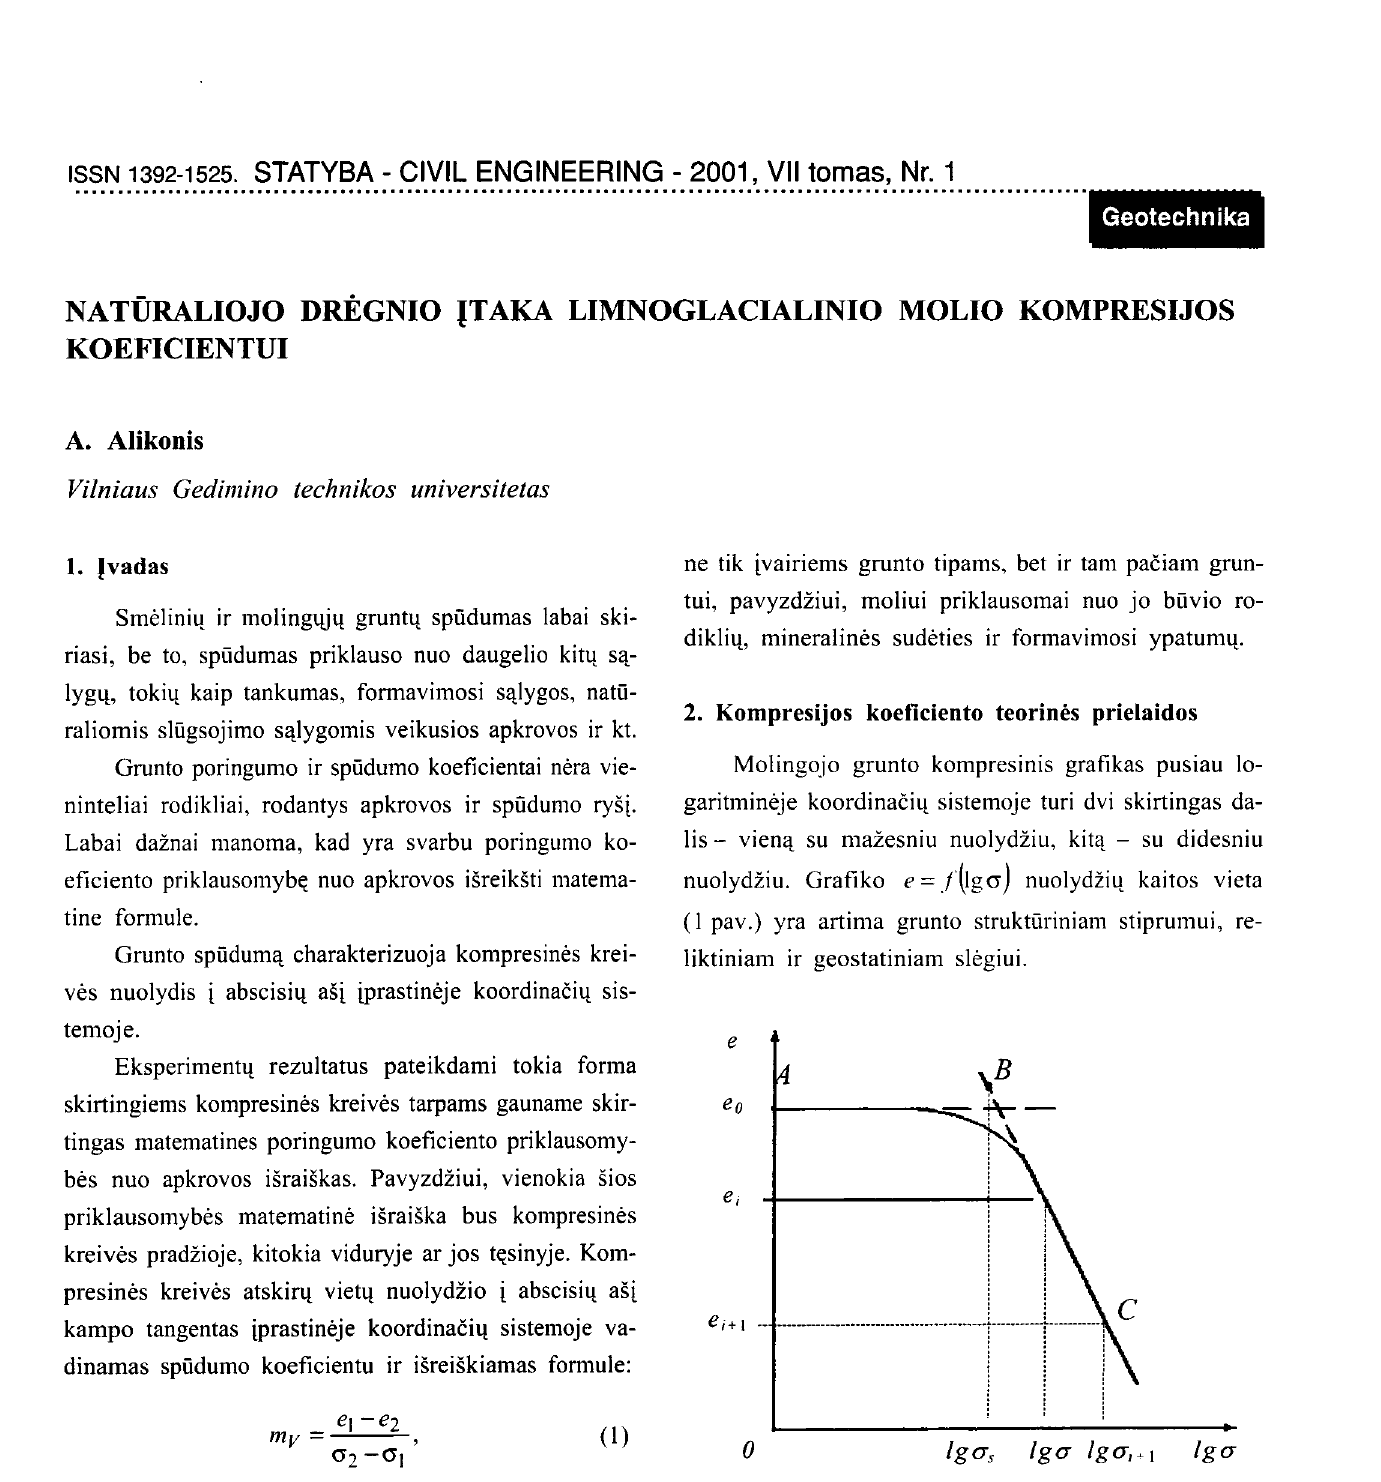
Fig 1. Compression curve of clay in semi-logarithmic